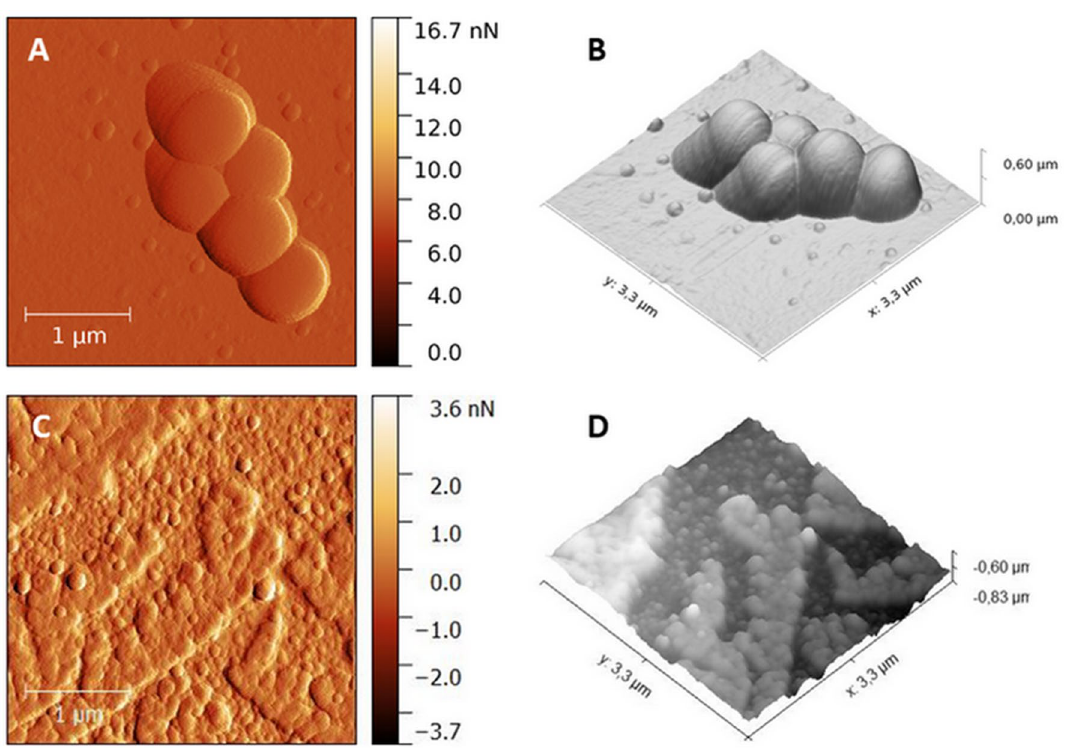
Figure 4. AFM 2D topography (left panel) and the corresponding 3D reconstructions (right panel) images of Methicillin-resistant S. aureus cells before therapy ( A , B , scan area: 3.3 µm × 3.3 µm) and after treatment by TPP-NPs with irradiated light dose of 3.24 J/cm2 ( C , D , scan area: 3.3 µm × 3.3 µm). Images were processed by Gwydion